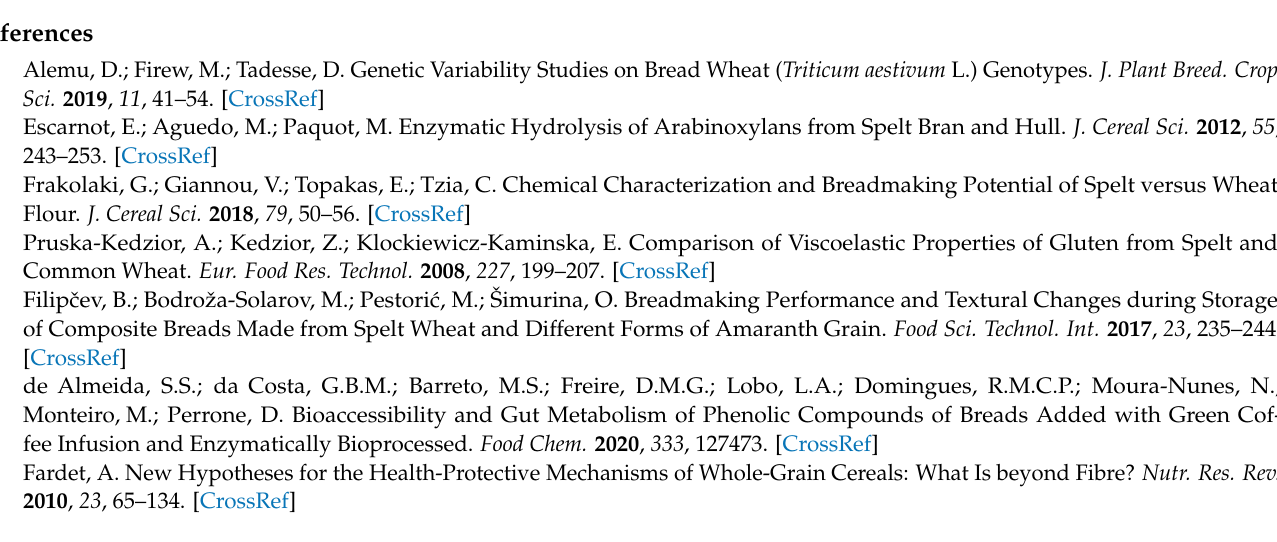
dough and wheat dough enriched with 2.5% (GFB2.5) and 5% (GFB5) “germinated + fermented” spelt flour; Figure S2: Extensiograms of control (wheat) dough and wheat dough enriched with 2.5% (GFB2.5) and 5% (GFB5) “germinated + fermented” spelt flour; Figure S3: Photographs of breads prepared from white wheat flour (control), with 5% of »germinated + enzymatic treated« spelt flour (GEB5), with 10% of pasteurised »germinated + enzymatic treated« spelt flour (GEB10P), with 30% of